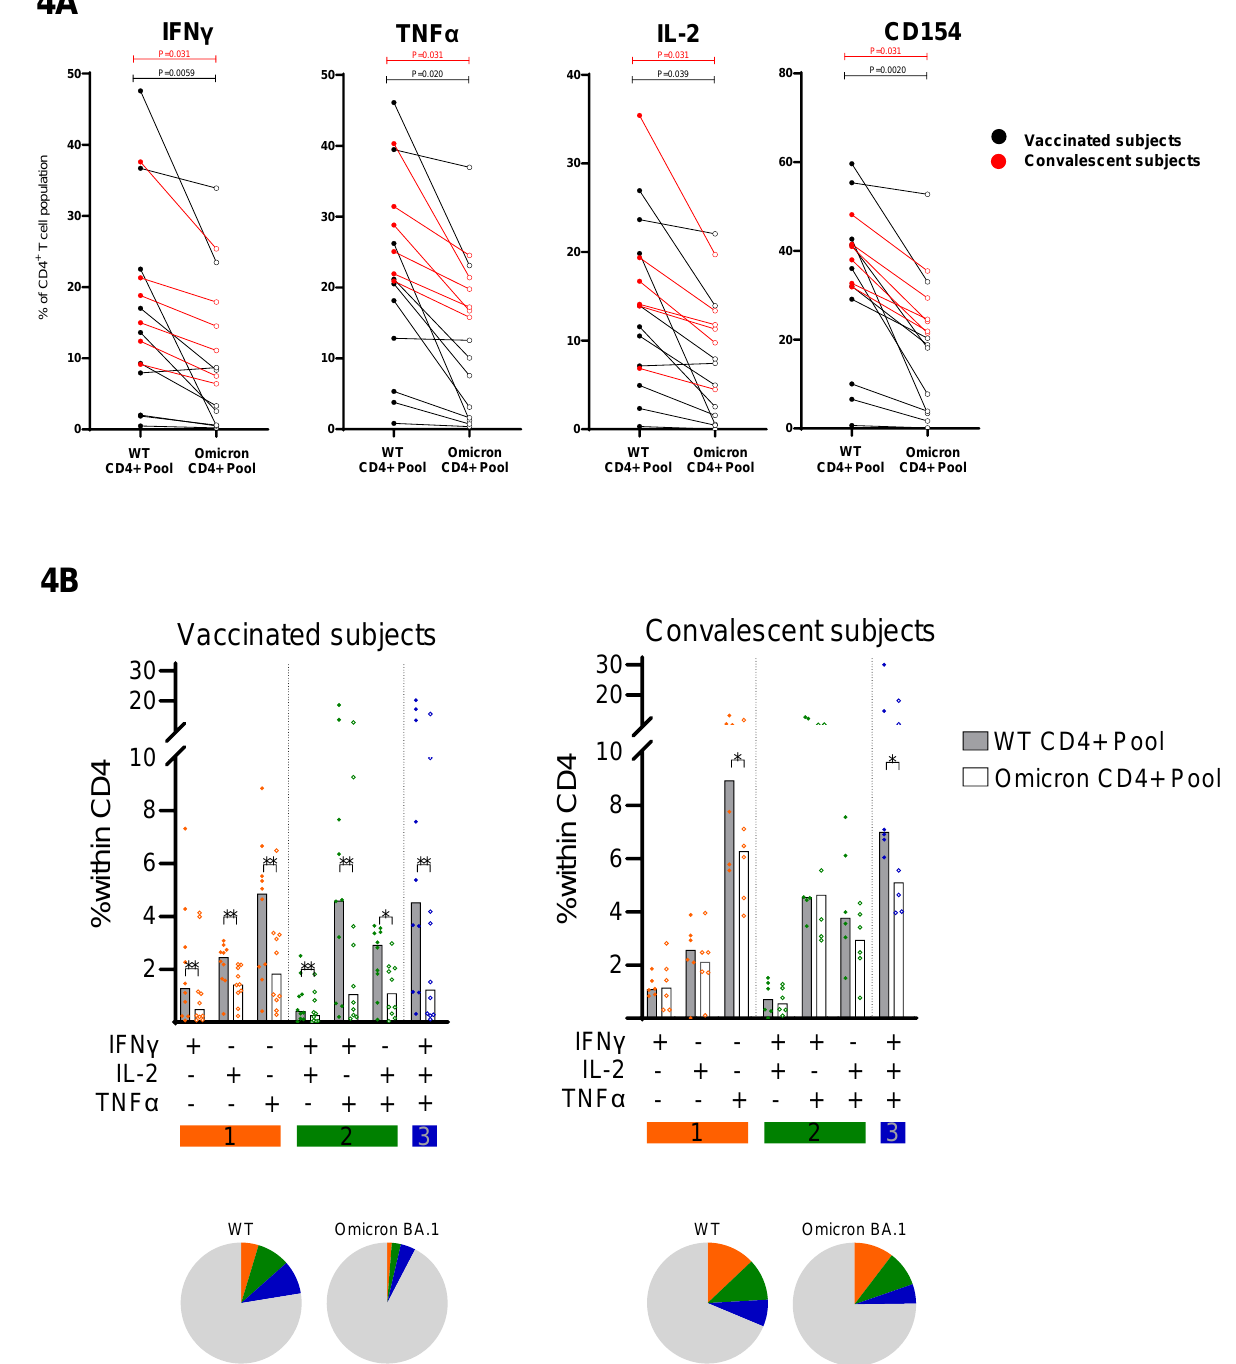
Figure 4. In-depth characterization of reduced cross-reactivity of spike-specific T-cell lines to Omicron BA.1 variant. Polyclonal-epitope-specific T-cell lines were analyzed for functional marker expression by flow cytometry after stimulation with peptide pools of spike protein of D614G wild-type (WT) strain versus Omicron BA.1 variant. ( A ) T-cell lines were generated by 14-day in vitro stimulation of PBMCs from vaccinated (black dots/lines) and convalescent subjects (red dots/lines) with a pool of selected CD4 + T-cell epitope candidates from the WT strain (“WT CD4 + pool”). Subsequently,